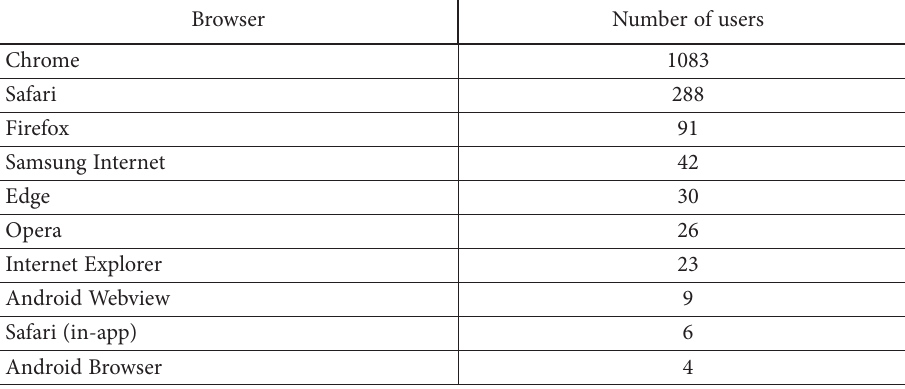
Table 5. Number of users by browser type (source: created by authors)